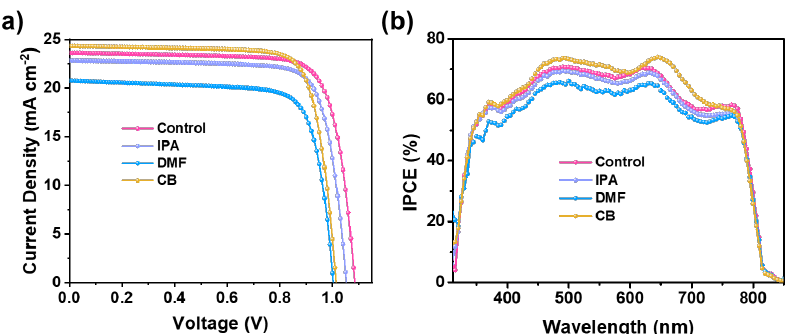
Figure 5. ( a ) The best JV curves and ( b ) IPCE curves of PSCs fabricated under different atmos- pheres.